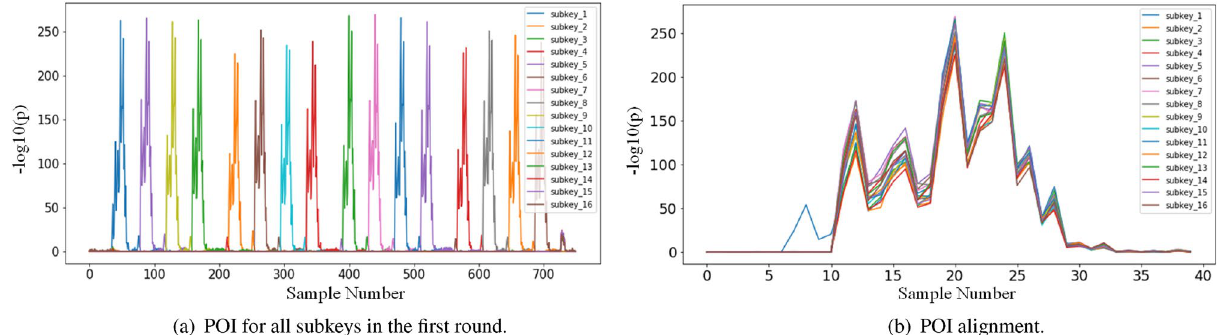
Figure 5. The result of all subkey POI and the result of POI alignment (AES_STM32).